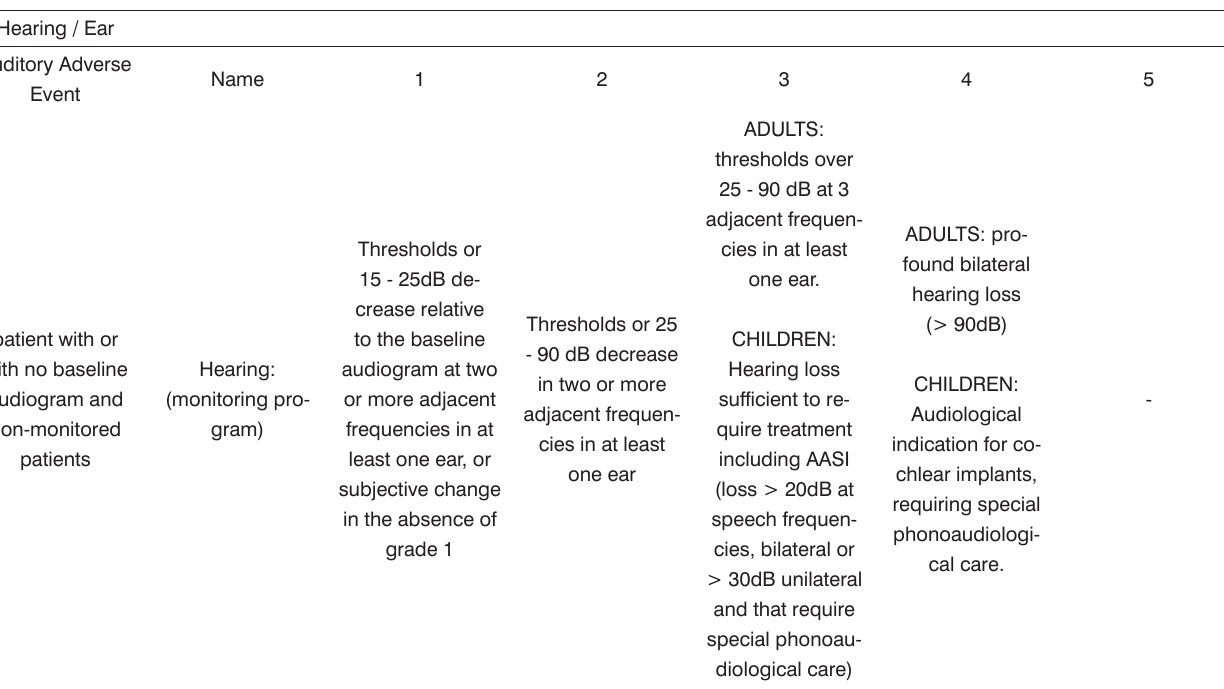
Annex 1. Table of the NCI proposed classification Common Terminology Criteria for Adverse Events (CTCAE) (2003) Cancer Therapy Evaluation Program, Common Terminology Criteria for Adverse Events Version 3.0 DCTD, NCI, NIH, DHHS. March31, 2003 (http:// ctep.cancer.gov) Publishing date, 10 June